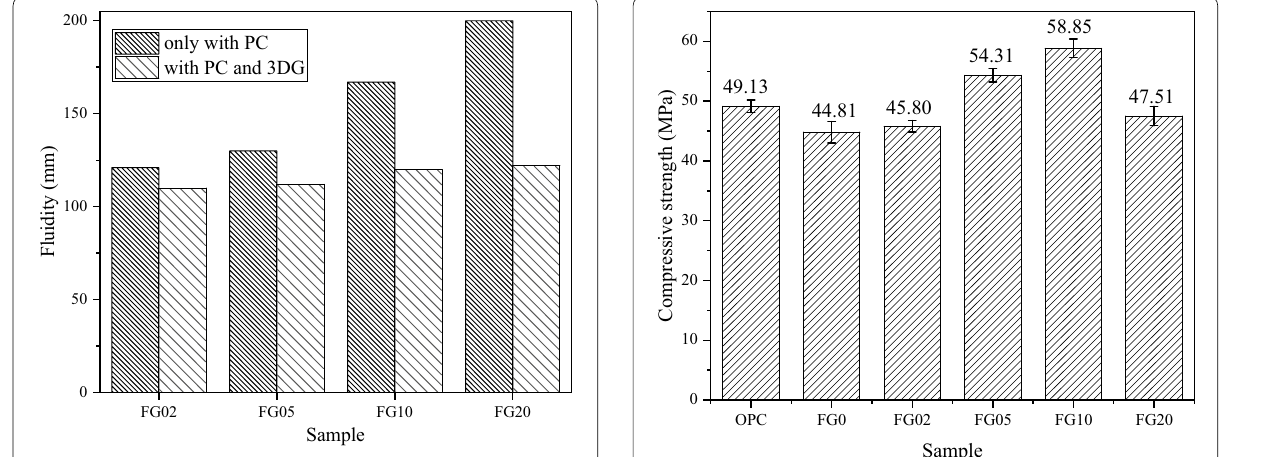
Fig. 8 The fluidity of the fly ash cement paste.